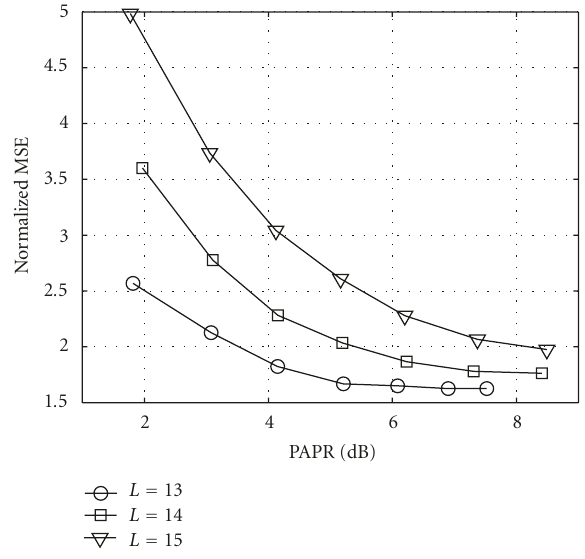
Figure 5: Normalized MSE versus PAPR for three di ff erent lengths of CIR in a UW